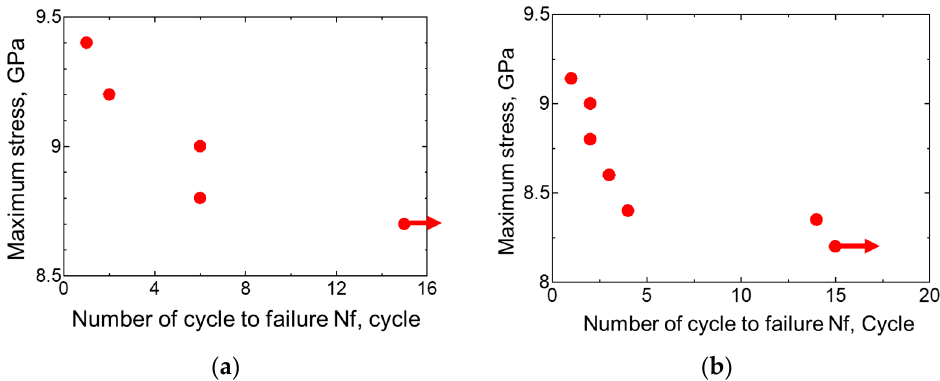
Figure 18. Relationship between interfacial strength and the number of loading cycles required for crack initiation in Model 1 ( a ) and Model 2 ( b ) according to MD simulations. crack initiation in Model 1 ( a ) and Model 2 ( b ) according to MD